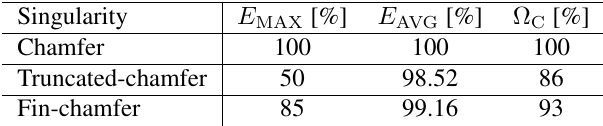
Figure 11: E AVG as a function of Ω for the three investi- gated singularities. The variation of E AVG with respect to the singularity end-tip shape is modest, though a monotonic increase of E AVG for increased singularity sharpness can be appreciated. No dependence on L MAX is found. Table 1: Relative variations of E MAX , E AVG , and Ω C for the three singularities investigated. E MAX compared at L MAX = 1 µ m ; E AVG compared at Ω = Ω C , AVG , where Ω C , AVG ∼ 0 . 06 mm 3 is the arithmetic average of the Ω C of the three investigated singularity shapes. The values are expressed in percentage using the chamfer as